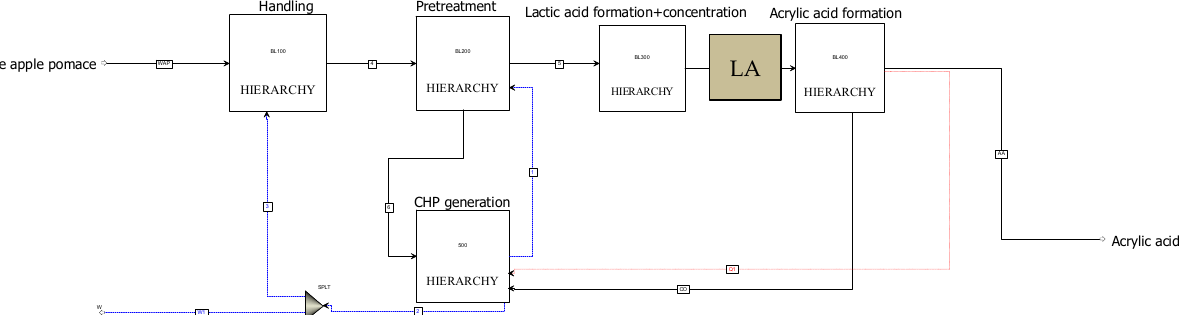
Figure 3. Aspen Plus output for AA production from WAP via the fermentation–dehydration (FD) pathway (black continuous lines, red dash lines and blue dashed line denote material, heat and work flows).